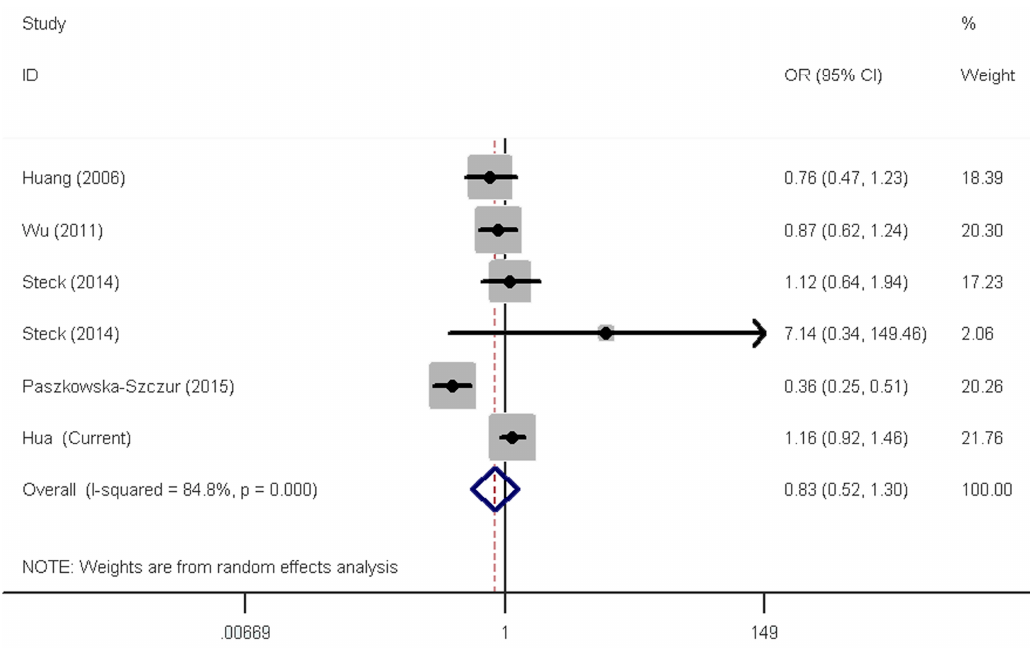
Figure 2. Forest plot of effect estimates for XPC rs2228000 C > T polymorphism with overall colorectal cancer risk by a recessive model. For each study, the estimates of OR and its 95% CI are plotted with a box and a horizontal line. ◊ , pooled ORs and its 95%